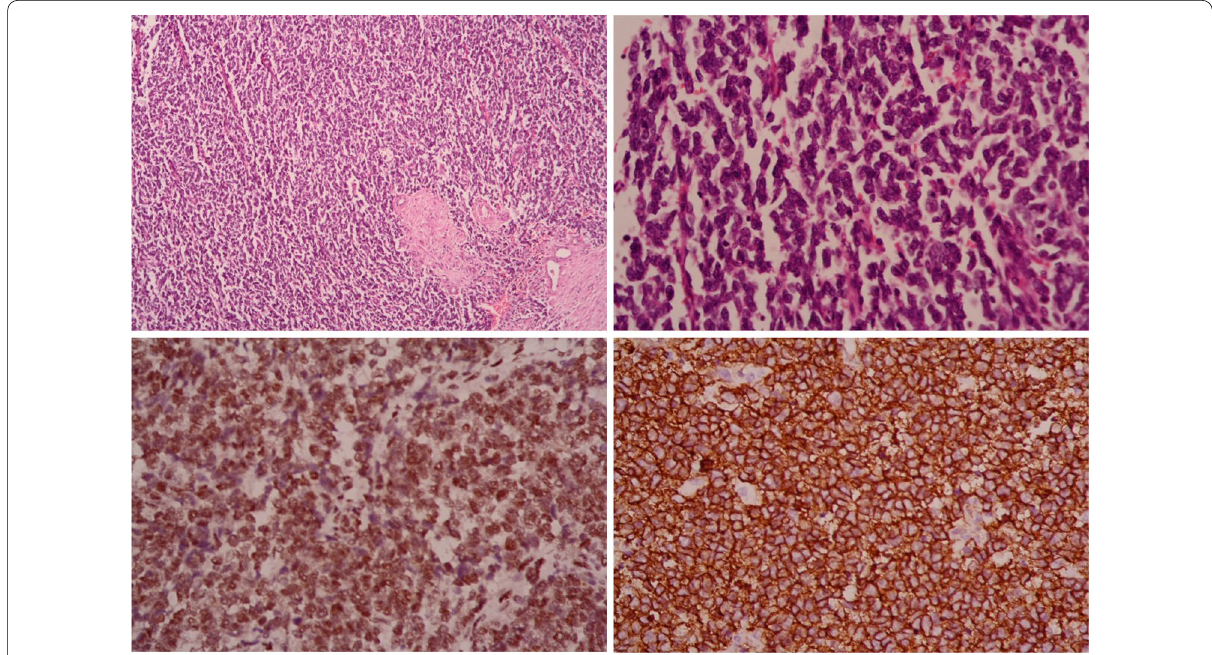
Fig. 2 A and B Hematoxylin and eosin stained tissue with 10 FLI-1-Tumor cells with nuclear